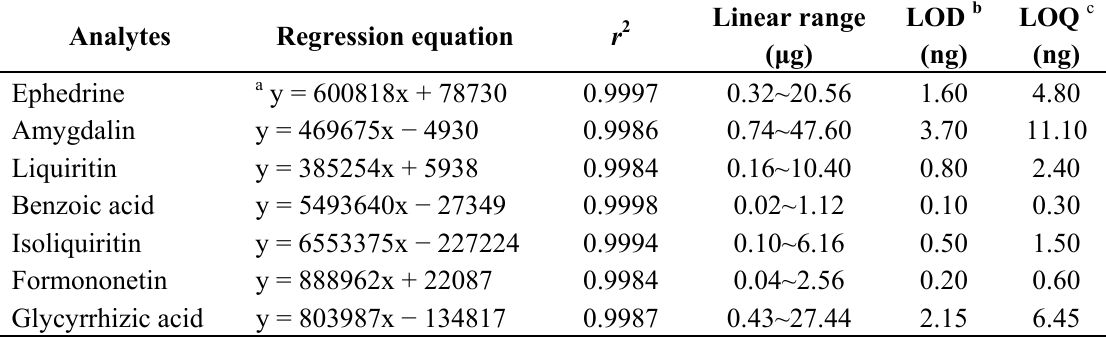
Table 2. Regression equation, correlation coefficients, linearity ranges, limits of detection (LOD) and limits of quanti fi cation (LOQ) of investigated